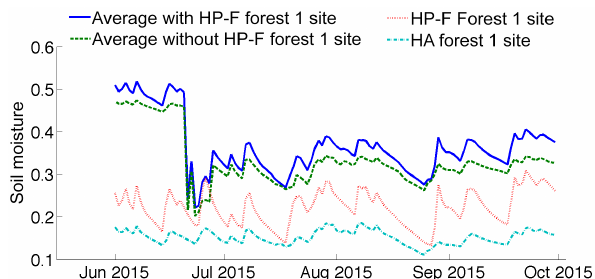
Figure 7. Illustration of the impact of the new station (HP-F for- est 1) installation on spatially weighted average top-layer soil mois- ture in comparison to average soil moisture without the new station between 1 June 2015 and 30 September